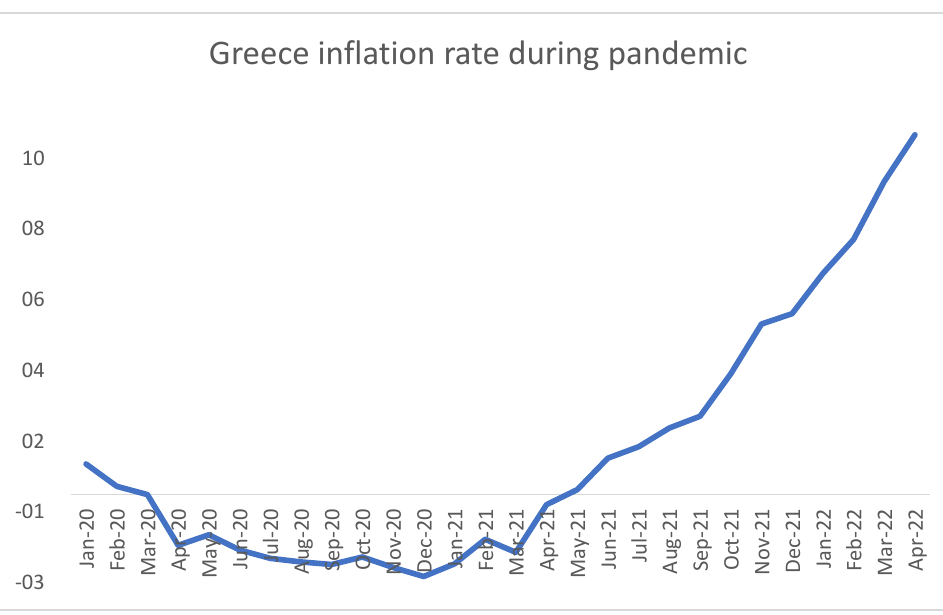
Figure 4. Inflation rate in Greece during the pandemic crisis. Source: Eurostat.